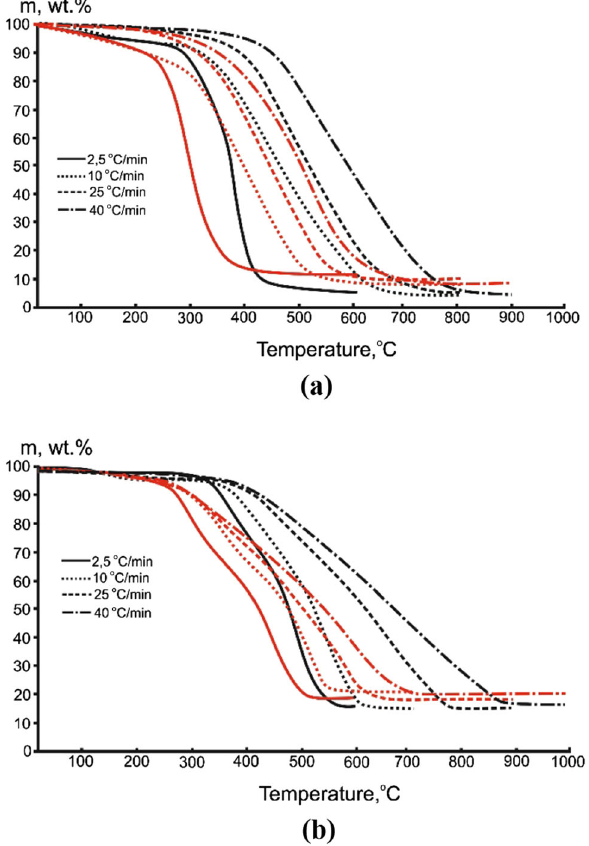
Fig. 7 TG-curves for the oxidation of the coal samples at different heating rates. a L series samples; b B series samples. Initial samples are denoted by a black line, the modified samples are denoted by a red